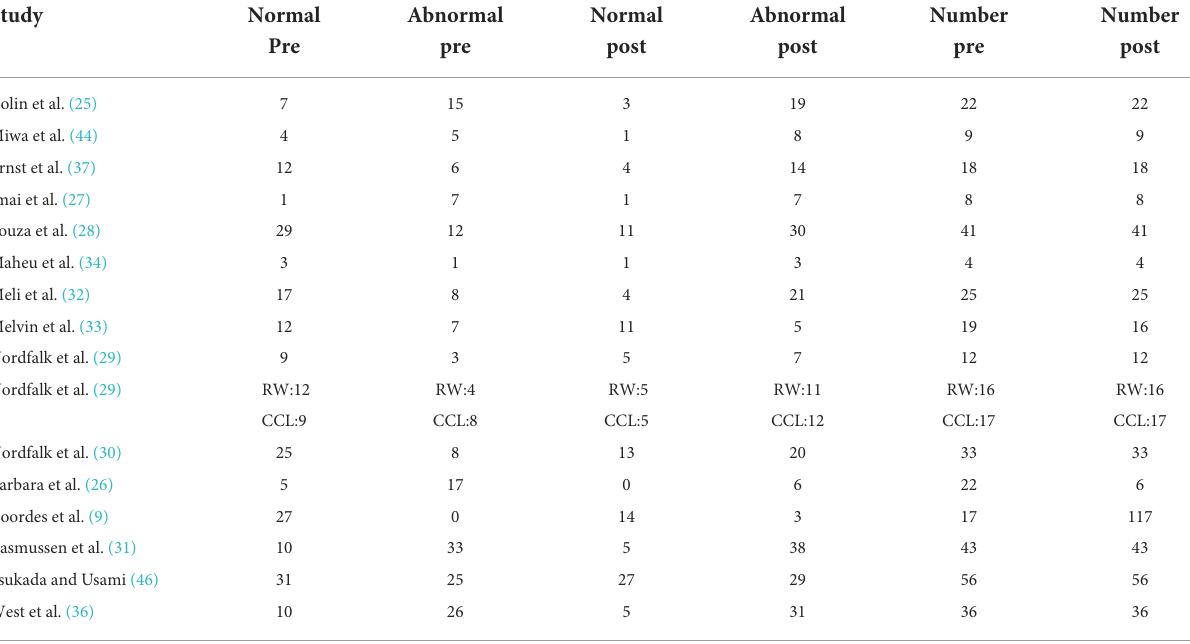
TABLE 2 Number of subjects with normal and abnormal testing results before and after surgery in studies included in the meta-analysis for the VEMP test. Study Normal